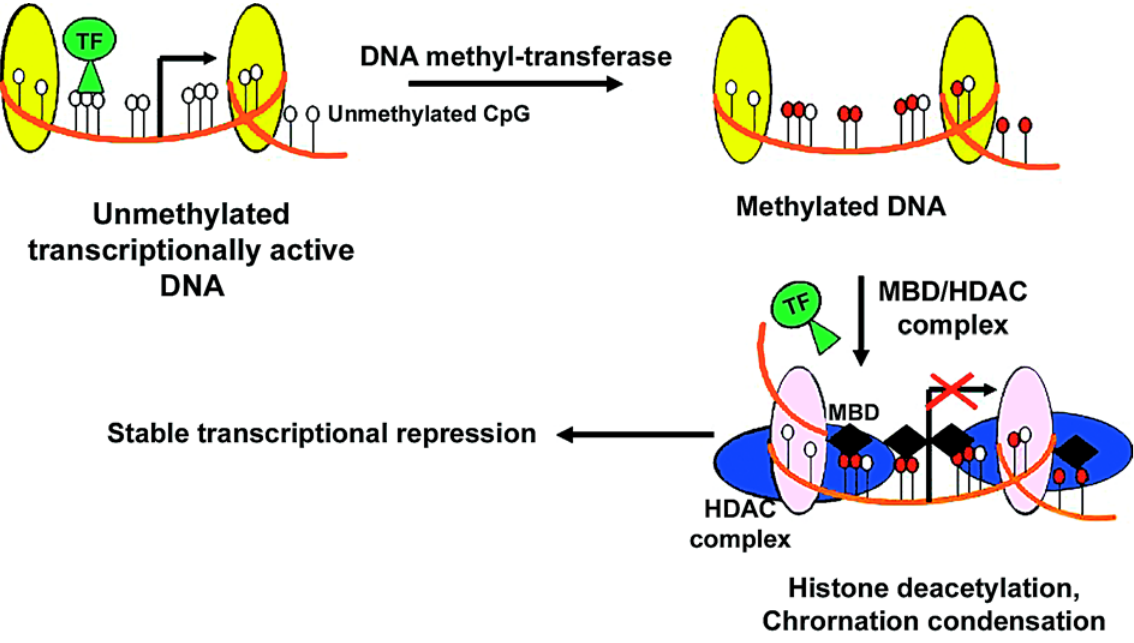
Figure 1 – Epigenetic silencing of gene expression. DNA methyl-transferases carry out the methylation of CpG dinucleotides, which triggers the process of gene silencing by recruitment of methyl binding domain (MBD) and Histone deacetylases (HDAC) to bind to the methylated DNA. This results in histone deacetylation and chromatin condensation leading to loss of transcription factor binding and subsequent repression of